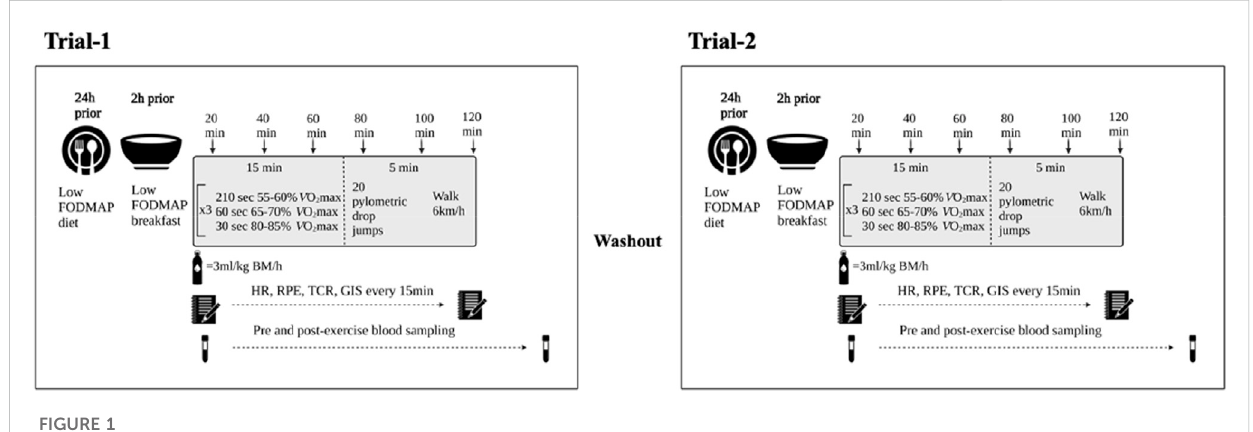
FIGURE 1 Schematic illustration of experimental